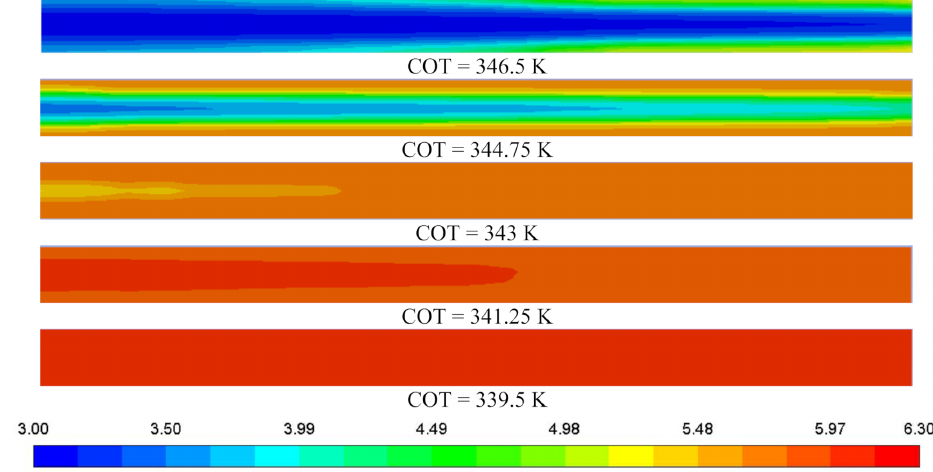
Figure 12. Water content distribution under the fluctuation of